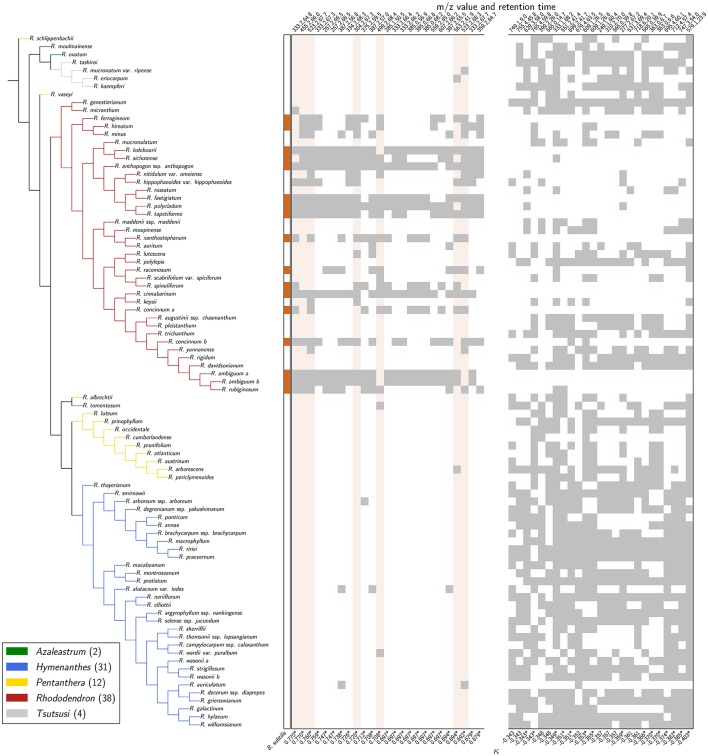
The 25 most- and least-predictive LC-MS peaks with respect to Cohen's kappa correlation for antimicrobial activity across all 87 Rhododendron species mapped against their phylogeny. A sample is denoted as antimicrobial active (orange) if the radius of the agar diffusion assay is ≥0.6 cm. A compound, defined by an m/z ratio and retention time tuple, is denoted as present in a sample (gray) if its intensity is ≥10,000. The * emphasizes significant correlations with respect to multiple testing correction by Benjamini-Hochberg (α = 0.05). The seven most-predictive peaks regarding antimicrobial activity and non-cytotoxicity at once are highlighted in bright orange.